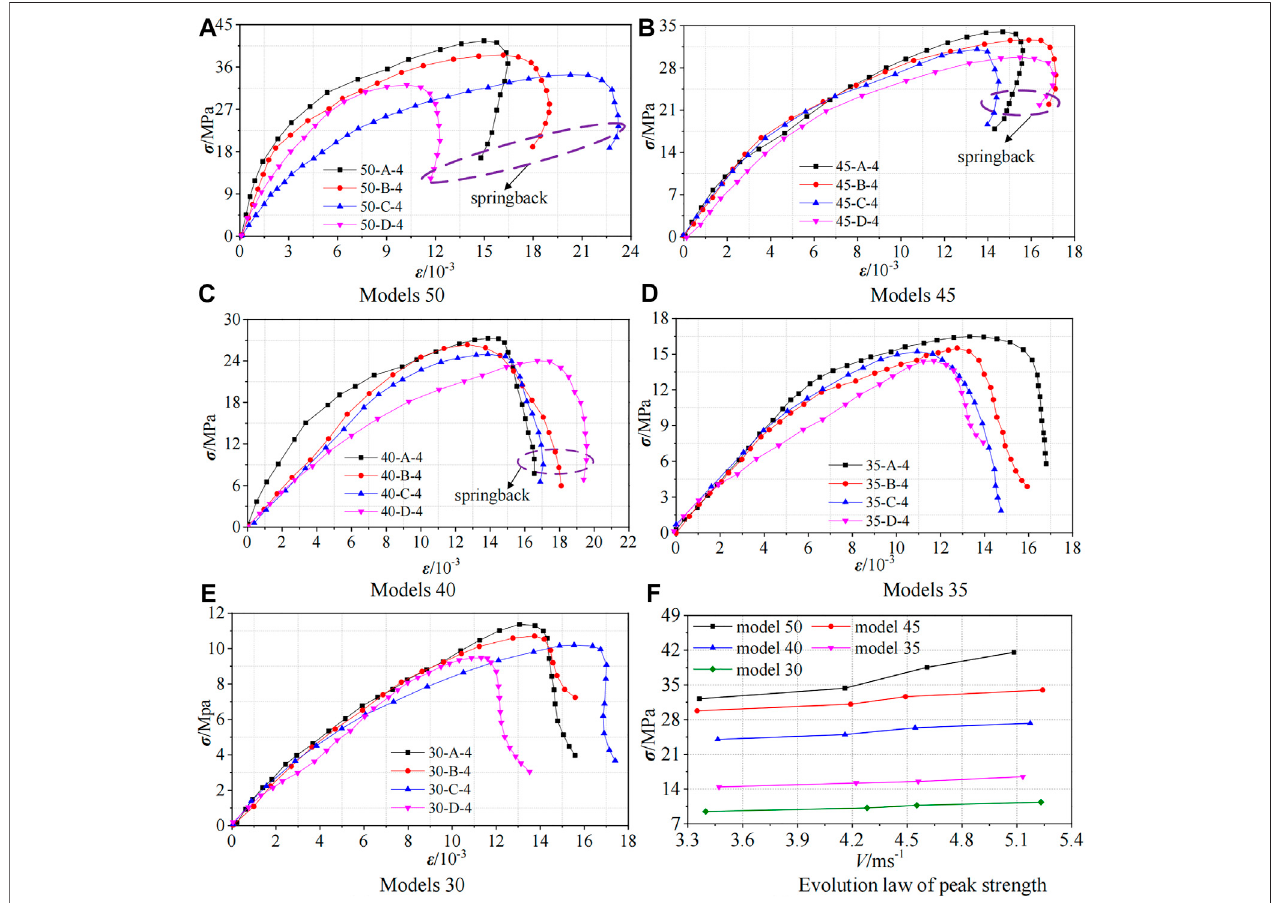
FIGURE 9 | (A – E) Strength evolution of specimens under different dynamic loads with 8 MPa pre-static load; (F) Evolution law of peak strength of each model.